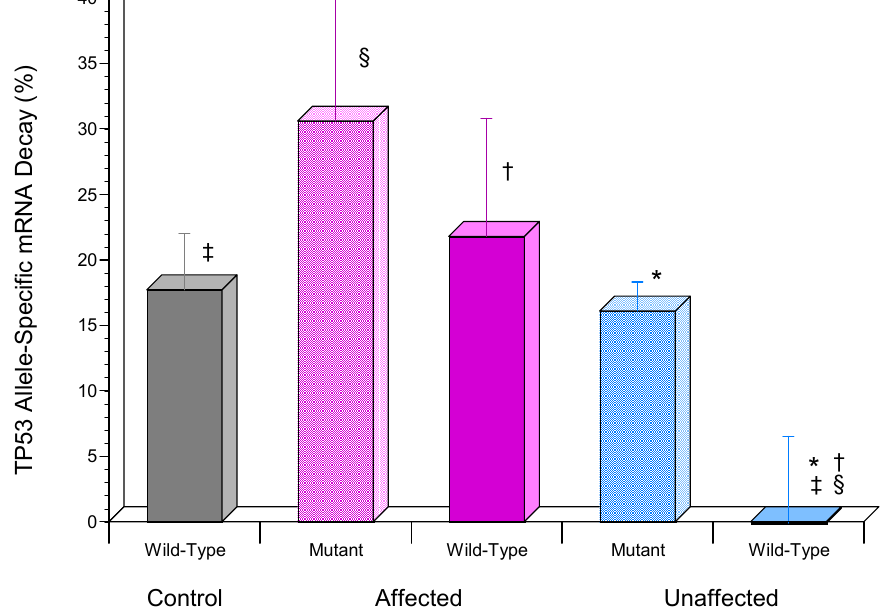
Figure 6. Wild-type TP53 allele-specific mRNA stabilization in dFb from unaffected compared to affected LFS or control subjects following UV exposure. RT-PCR-RFLP assay customized to detect the heterozygous Ser241Tyr C > A TP53 mutation in this LFS family was used to calculate propor- tions of wild-type and mutant TP53 mRNA remaining 6 h after transcriptional inhibition with acti- nomycin D following UV irradiation, as described ( n = 4: * p < 0.05, unaffected wild-type vs. unaf- fected mutant; † p < 0.05, unaffected wild-type vs. affected wild-type; § p < 0.05, unaffected wild-type vs. affected mutant; ‡ p < 0.05, unaffected wild-type vs. wild-type control). Expression of TP53 allele mRNA was normalized relative to B2M mRNA as a stable reference standard. 4. Discussion This study was designed to further characterize the potential dysregulation of cell cycle arrest [17] and TP53 allele-specific expression [20] previously reported for fibroblasts from an LFS unaffected carrier compared to his affected offspring in response to UV stress [18]. Our previous study suggested that the reduced UV induction of CDKN1A /p21 mRNA and protein expression by the affected dFb [18] could dysregulate p21-dependent cell cycle arrest response to UV stress [47], as has also been reported in affected dFb with other TP53 mutations [17]. Therefore, the first portion of the present study was designed to examine the signal transduction pathway regulating the cell cycle response to UV exposure. Phosphorylation of the cell cycle checkpoint kinases 1 (Chk1) and 2 (Chk2) [30], substrates of the key DNA damage protein kinase sensors, ATR and ATM, respectively [29], was selected for this analysis. This comparison found significantly increased phospho-Chk1[S345] in protein extracts from the affected dFb compared with both the unaffected and control dFb follow- ing UV exposure (Figure 1), whereas no significant UV-induced phospho-Chk2[T68] was found in any of the dFb tested. Unexpectedly, this UV-induced increase in phospho- Chk1[S345] was found to potentially be reinforced by the previously observed UV-in- duced phospho-p53[S15] upregulation in the affected dFb [18], since it has been shown that phospho-p53[S15] may play a role in sustaining activated phospho-Chk1[S345] [33]. In short, this increased phospho-Chk1[S345] would suggest a stronger cell cycle ar- rest response to UV exposure [48] in the affected dFb (Figure 1). Such a response would appear to potentially be at odds with the reduced UV induction of CDKN1A /p21 mRNA and protein expression by the affected dFb found in previous studies [17,18], which was suggested to be indicative of an aberrant p21-dependent cell cycle arrest response [47].